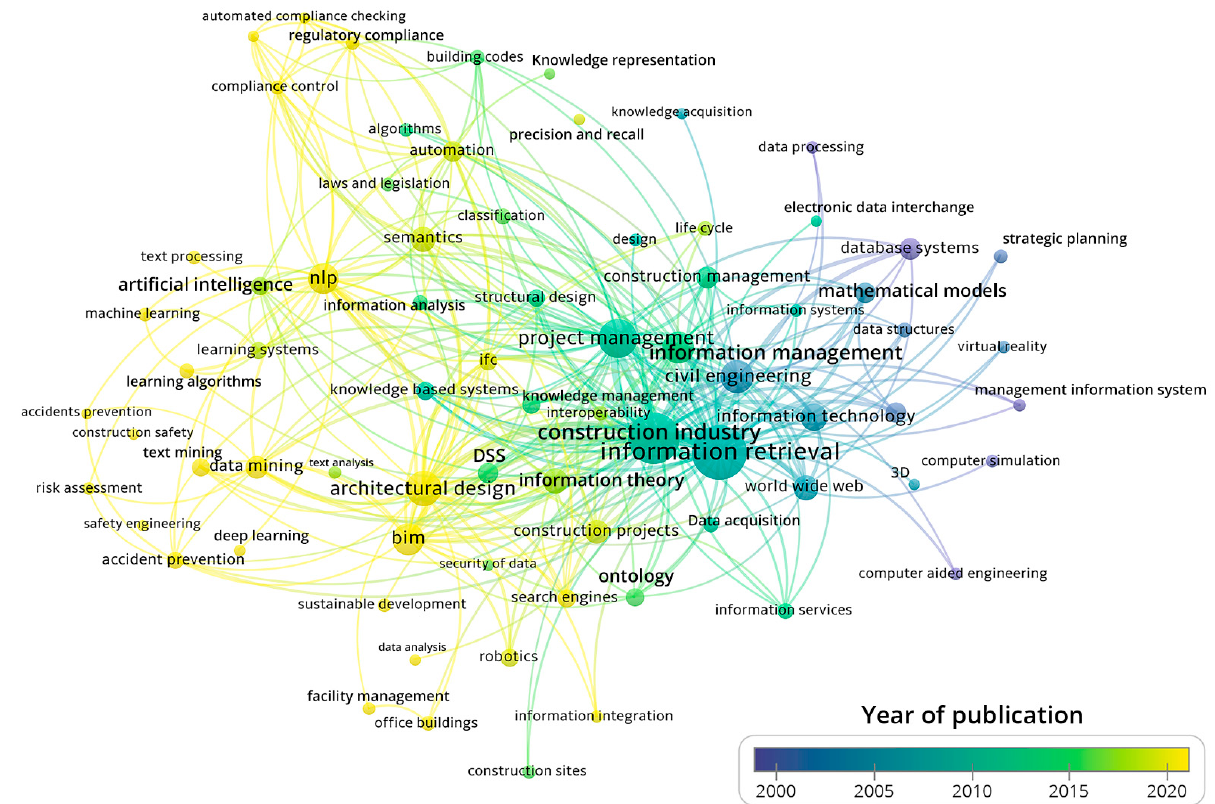
Figure 8. Co-occurrence keyword with temporal overlay data. Software: VosViewer version 1.6.15. Table 4. Cluster topic average publication